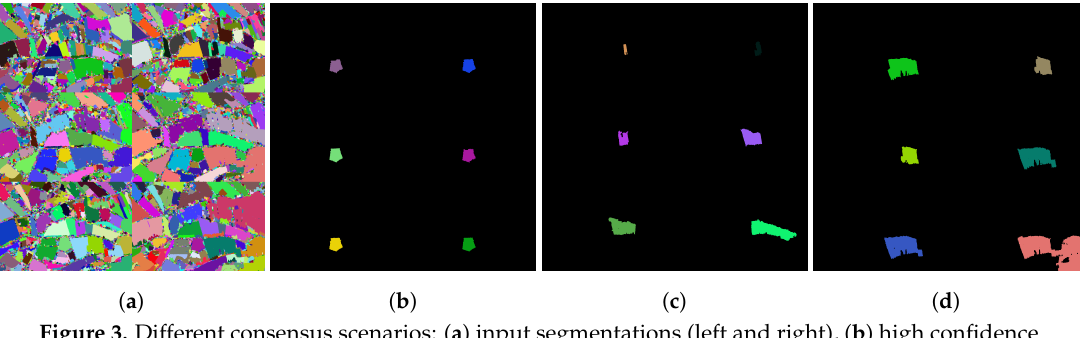
Figure 3. Different consensus scenarios: ( a ) input segmentations (left and right), ( b ) high confidence (consensus between regions of the two segmentations), ( c ) low confidence (mismatch between regions), ( d ) high confidence (regions are nested within others). Pseudo-colors are randomly generated from region labels providing one different color per